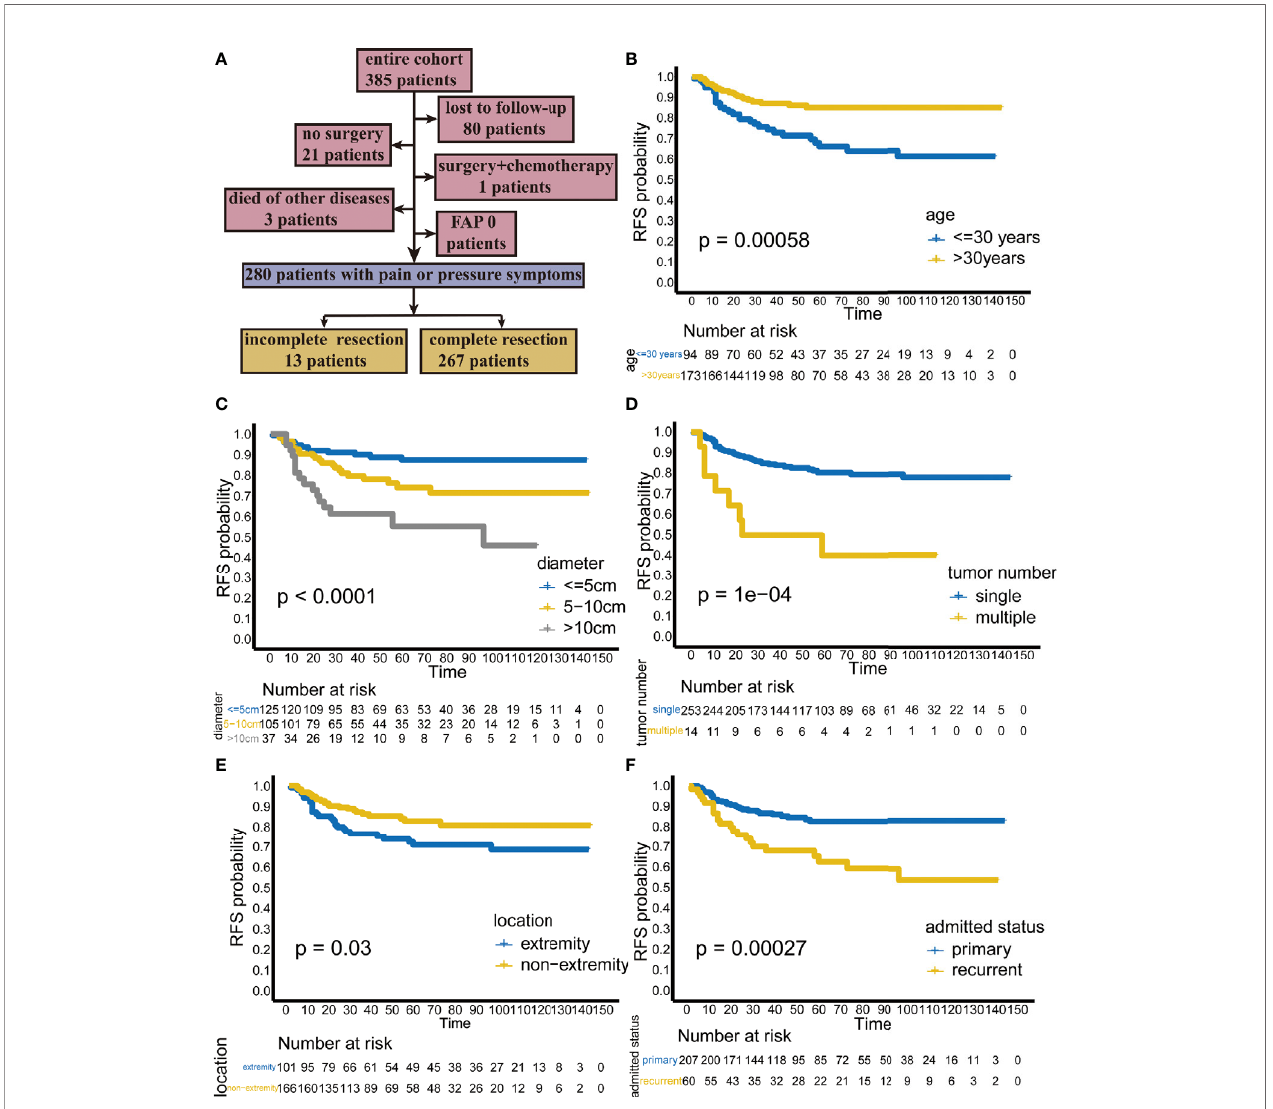
FIGURE 1 | (A) Flow chart of patient selection. Kaplan-Meier analysis showing the recurrence-free survival (RFS) rate strati fi ed by (B) age, (C) diameter, (D) tumor number, (E) location, and (F) admission